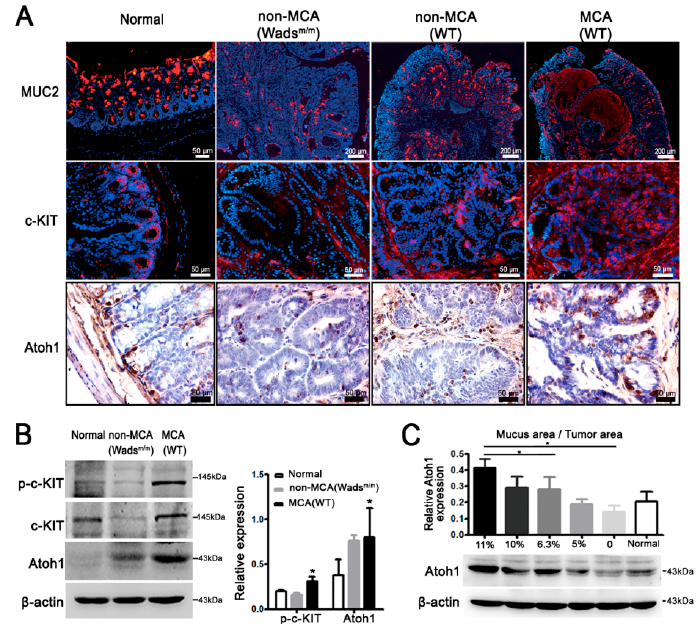
Figure 2. c-KIT increased mucin2 (MUC2) and Atonal homologue 1 (Atoh1) expressions in mice. ( A ) MUC2 was primarily expressed in goblet cells of normal colon and occupied the extracellular mucus in WT-MCA tissues, while very few MUC2 were detected in non-MCA of WT and Wads m/m mice. C-KIT and Atoh1 were located in the basal crypts of normal colon and had more potent immunostaining intensities in MCA compared with non-MCA; ( B ) Western blot showed higher expressions of c-KIT, p-c-KIT, and Atoh1 in MCA than those in non-MCA; * p < 0.05; and ( C ) Atoh1 was gradually increased with the increase in the mucus area, * p < 0.05. All values are mean ± SEM of three independent experiments unless otherwise stated.